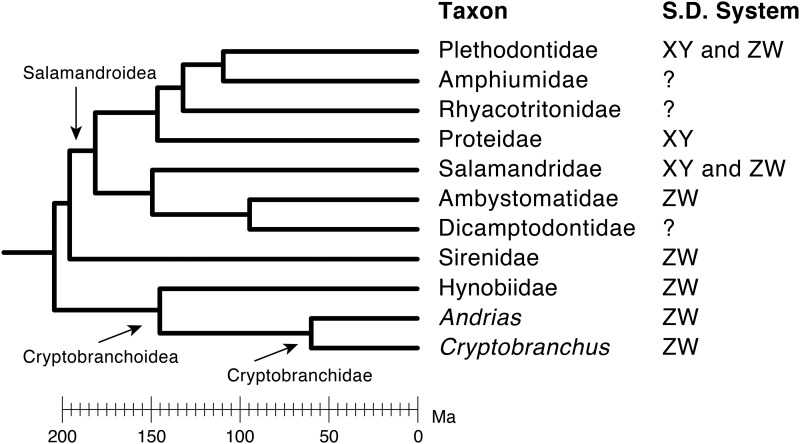
Family-level relationships among extant salamanders are depicted, along with the distribution of XY (male heterogametic) and ZW (female heterogametic) sex determination (S.D.) systems. Families for which S.D. mode is not known are indicated with a question mark. Divergence times are based on Kumar et al. (2017) and units are in millions of years before present (Ma). Information about sex determination systems is from León and Kezer (1974), Ikebe et al. (2005), Sessions (2008), Smith and Voss (2009), and this study.